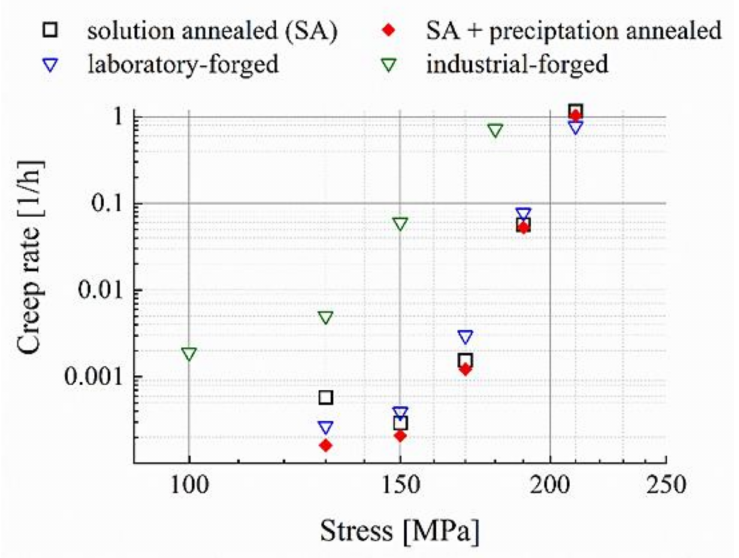
Figure 6. Creep rate over stress relations of the Fe17Cr2.6W1Nb trial alloy in various processing variants (650 ◦